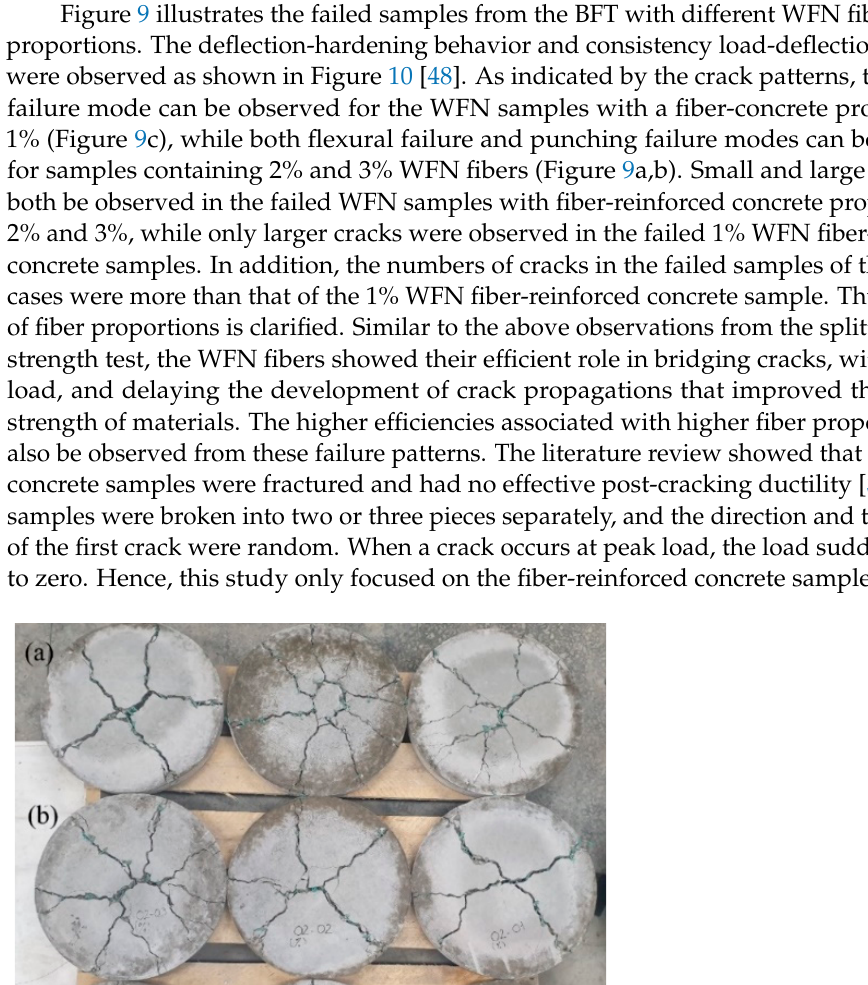
Figure 10. Load–deflection curves from the biaxial flexure test. The pre-peak stage, as illustrated in Figure 10, shows that the deformation mode de- pends on the elastic properties of the normal concrete. The pre-peak behaviors were sim- ilar for the three surveyed variables. Comparable effectiveness was observed with post- peak responses. Ductile behaviors can be observed owing to the addition of WFN fibers, and the improvement in this behavior is more evident with the higher WFN fiber propor- tions. In addition, different residual stages are observed among the three fiber proportions (3% WFN fiber-reinforced concrete >2% WFN fiber-reinforced concrete >1% WFN fiber- reinforced concrete). As the WFN fiber-reinforced concrete exhibited deflection-harden- ing behavior, the biaxial flexural stresses at the first crack (limit of proportionality (LOP)) and the peak (modulus of rupture (MOR)) were considered (see Table 8). At the point of LOP, the biaxial flexural stress remained unchanged when the fiber proportions were in- creased, and the difference between the highest and lowest stresses as compared with that